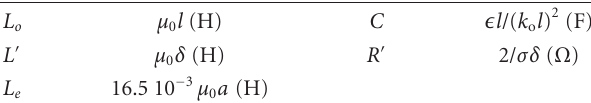
Table 1: Expressions for the circuit elements of Figure 2.